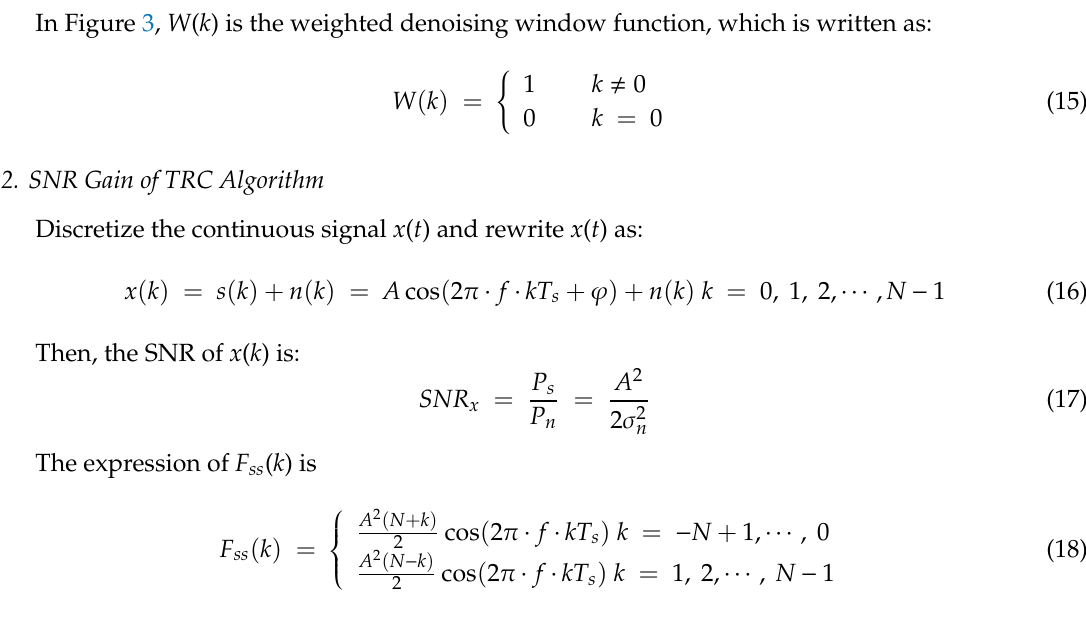
Figure 3. Line spectrum detection based on TRC algorithm.